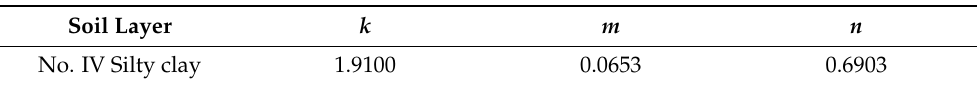
Table 12. Parameters of empirical creep model of silty clay in